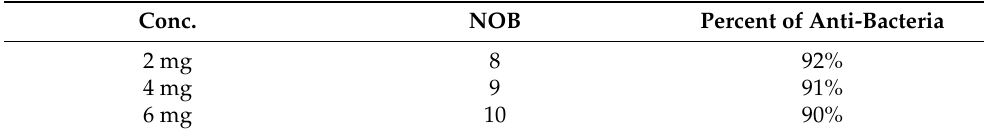
Figure 6. ( A ) Staphylococcus aureus (Gram-positive), ( B ) effect of 2 mg (GO-WO 2.89 ), ( C ) effect of 4 mg (GO-WO 2.89 ), ( D ) effect of 6 mg (GO-WO 2.89 ) on Staphylococcus aureus (Gram-positive) bacteria. Table 2. Number and percent of antibacterial effect by GO-WO 2.89 nanoparticles. Conc. NOB Percent of